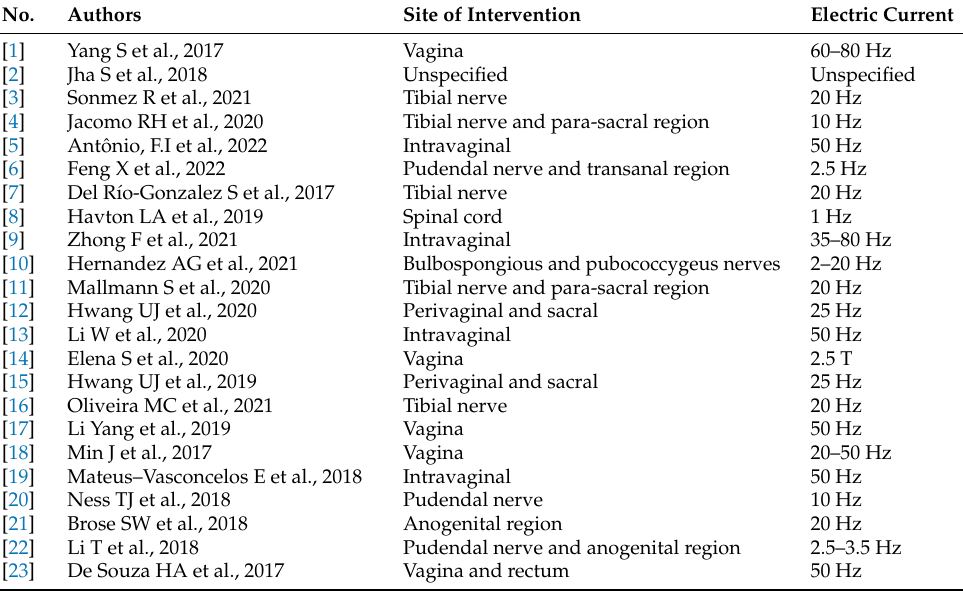
Table 3. Relation between electric current and site of intervention reported by the reviewed studies.